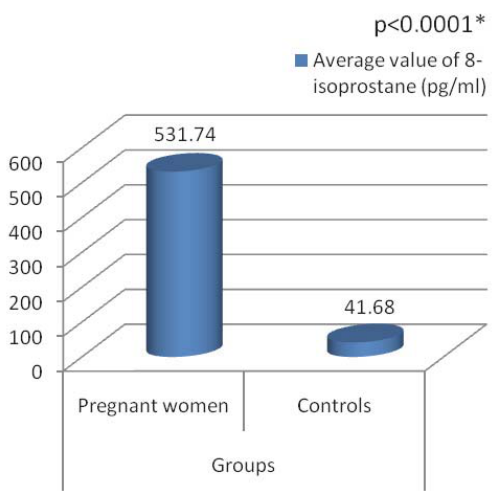
FIGURE 3. - 8 - isoprostane average values for the second trimester pregnant women and the control *p – signi fi cancy (if p<0.05 then there is signi fi cant correlation between investigated